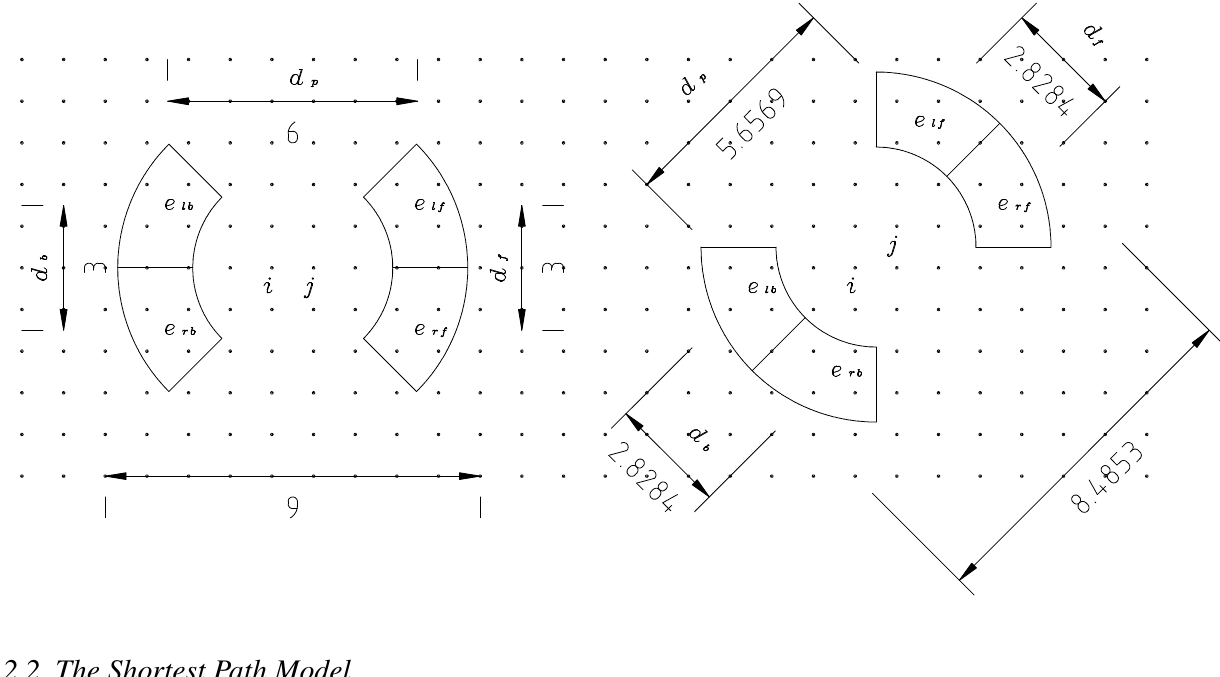
, e , e and e are the mean elevation at each wheel or bogie, and d lf rf lb rb